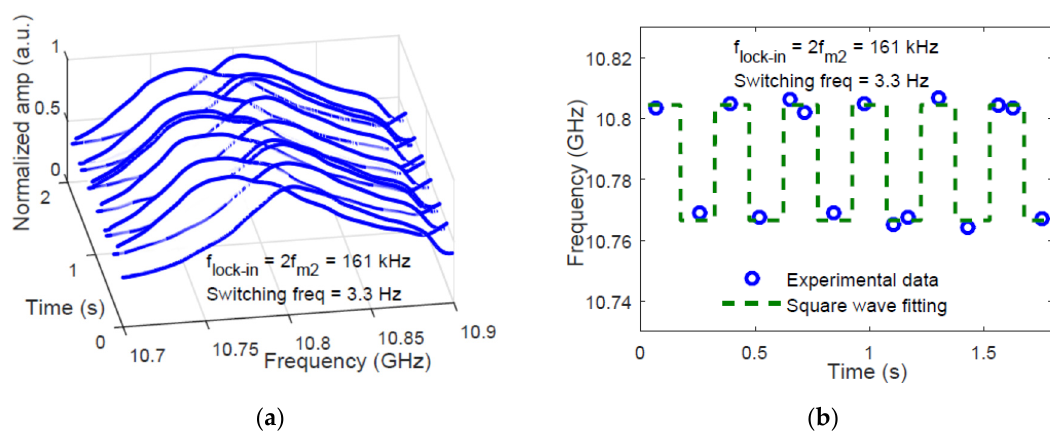
Figure 4. BOCDA measurements at two sensing locations simultaneously. ( a ) BGS acquired in the location subjected to BFS changes. ( b ) Corresponding BFS changes [42].